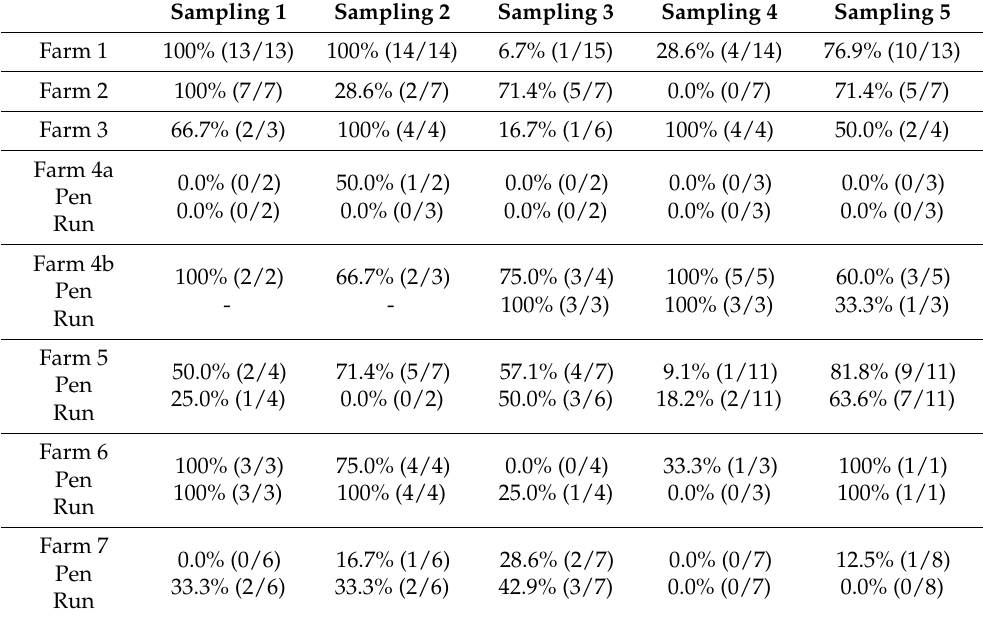
Figure 2. Average proportion of ESBL-positive pens per fattening pig farm in Mecklenburg-Western Pomerania (grey bars = conventional farms, grey bordered bars = organic farms; error indicators represent the 95% confidence intervals). Table 1. Proportions of ESBL-positive pens and runs in organically managed fattening pig farms in Mecklenburg-Western Pomerania per farm and farm visit in